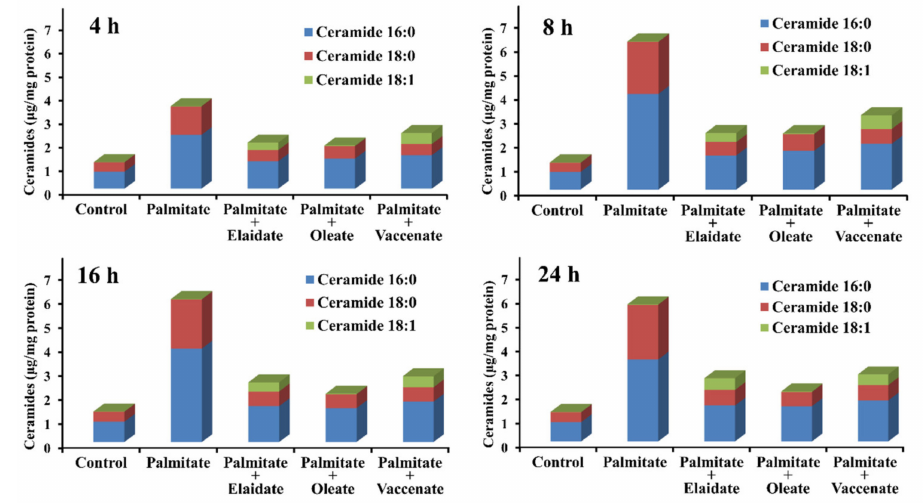
Figure 6. Changes in ceramide levels. Cells were treated with BSA (control cells) or BSA-conjugated palmitate alone, or with palmitate and one of the unsaturated fatty acids, elaidate, oleate or vaccenate at 250 µ M individual concentration for 8 h at 70%–80% confluence. The amount of three di ff erent ceramide species was measured by LC-MS / MS in the washed cell samples prepared after 4, 8, 16 or 24 h treatments. The detected ceramides contained either a palmitate (16:0) or a stearate (18:0) or a monounsaturated fatty acid of 18 carbons (18:1). Data were normalized to the protein content of the samples, and are shown as mean values of three independent experiments with two